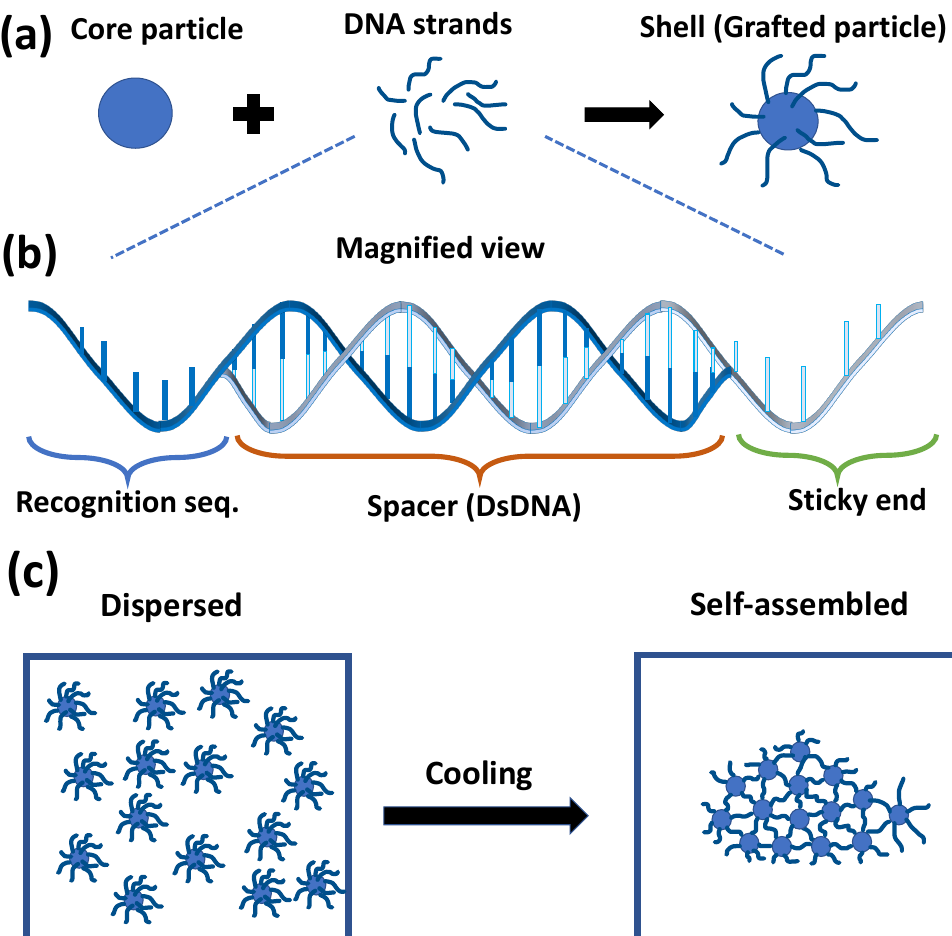
Figure 1. ( a ) is a cartoon representation of a DNA-grafted colloid. ( b ) shows the magnified view of the strands. The most general scheme of designing a DNA strand, for grafting purpose, involves a recognition sequence followed by a spacer and at the end there is sticky end. The recognition sequence is a sequence of unpaired bases that binds to the core particle. Spacer is used the control the overall length of the grafts. The sticky end has unpaired bases that hybridize with the sticky end of other building blocks. ( c ) is a cartoon to depict the assembly of DNA-grafted